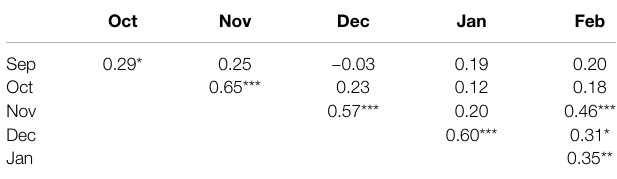
TABLE 1 | Correlation coef fi cients between the neighboring month snow cover from September to February of the following year in the selected key region over the eastern TP for 1979 – 2016. Symbol “ * ” , “ ** ” and “ *** ” denote correlation coef fi cients signi fi cant at the 90, 95 and 99% con fi dence level.